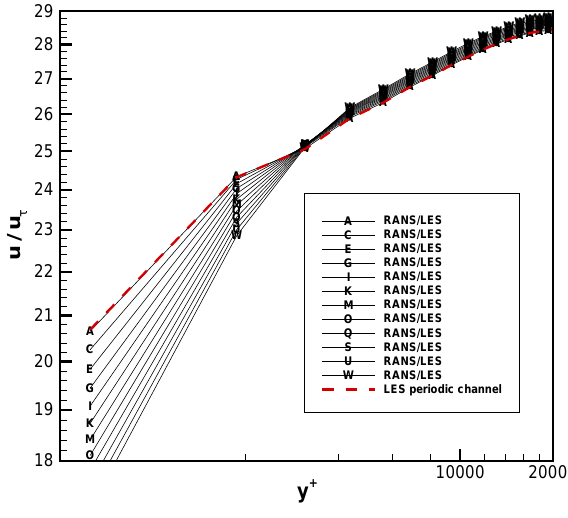
Fig. 4. Comparison of the mean velocity profile for nested channel flow simulation without body-force. Red dashed line: reference re- sults from the periodic channel simulation; black lines: mean veloc- ity profile at different sections of the channel with the buffer region.